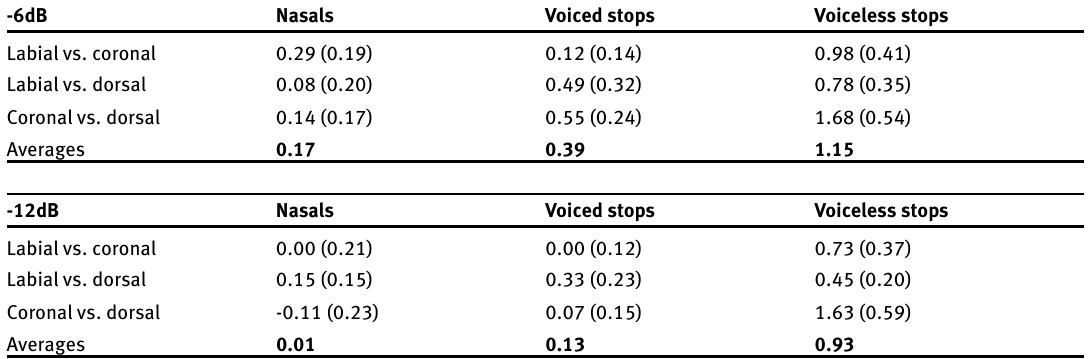
Table 4: The average d ′-values in Experiment IV (margins of errors for 95% confidence